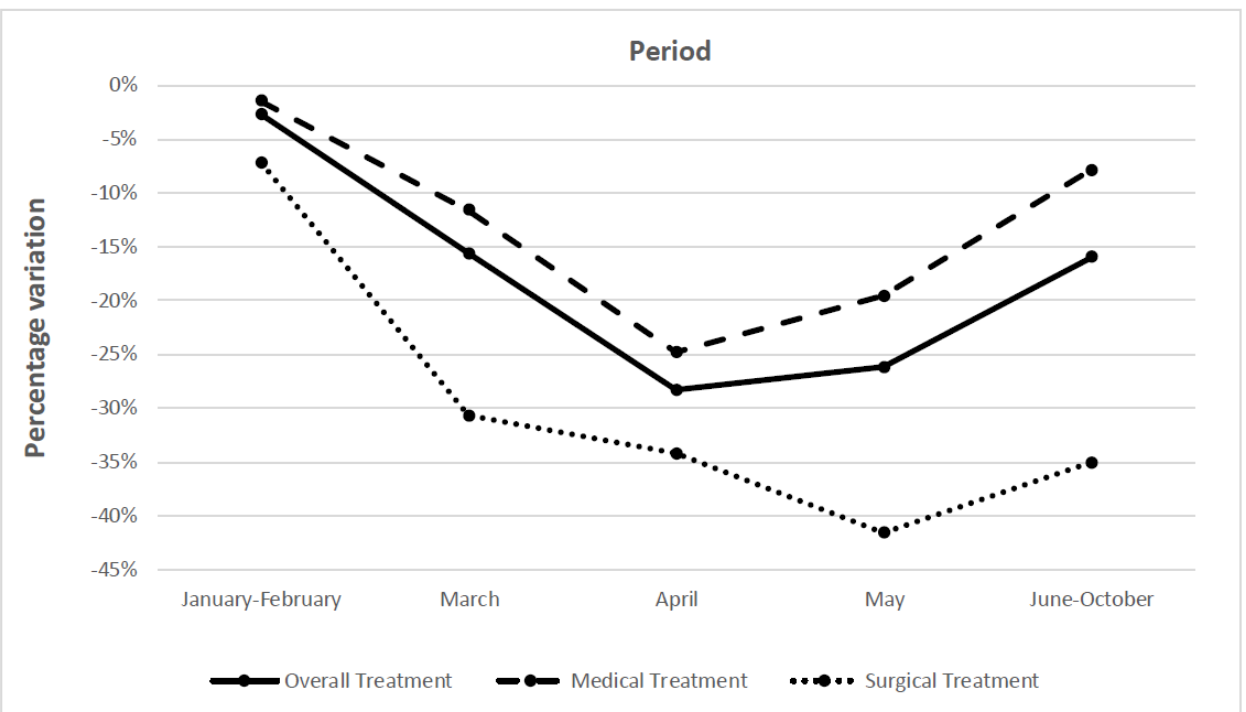
Figure 1. Weighted average variation of overall, medical, and surgical cancer treatment performed from January to October 2020 compared to the pre-pandemic period by time period.